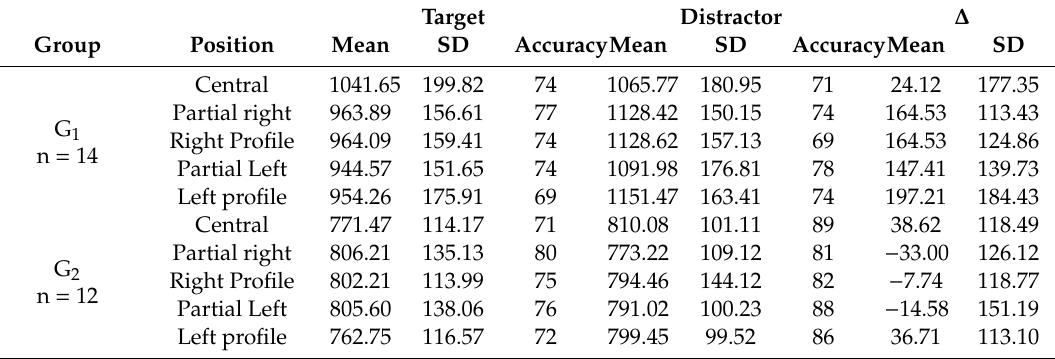
Table 3. Mean and SD (standard deviation), increments ( ∆ ) and e ffi ciency (%) in the clusters. Target Distractor